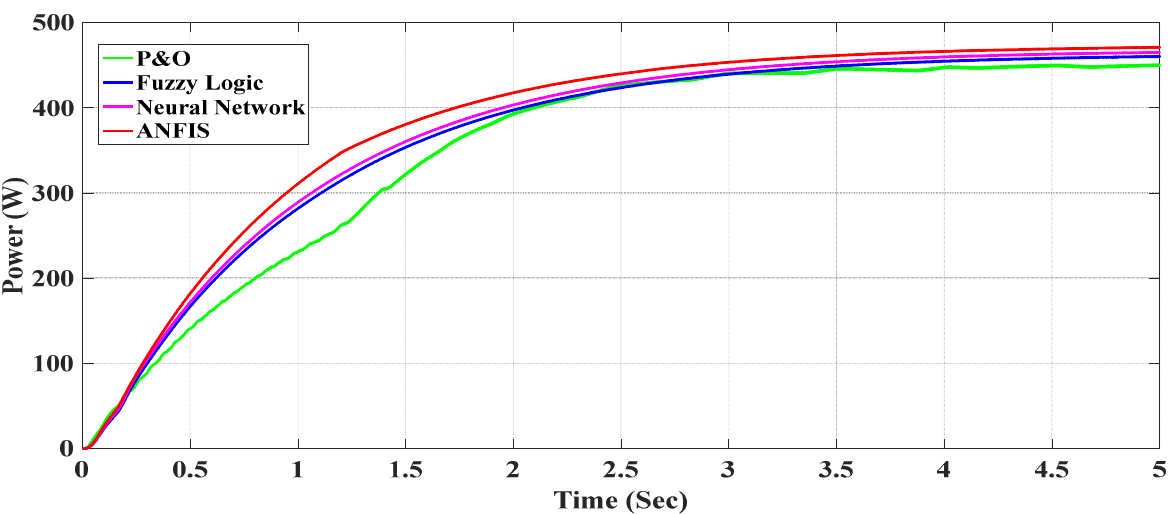
Figure 36. Output Power of WTIG Framework using P-&-O, F-LC, AN-N and AN-FIS MPPT Con- trollers to the variation in WS.